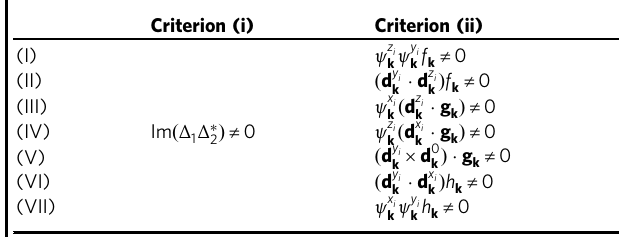
Table 3 Necessary conditions for the asymmetric Bogoliubov spectrum in two-band models ( σ μ ⊗ τ ν